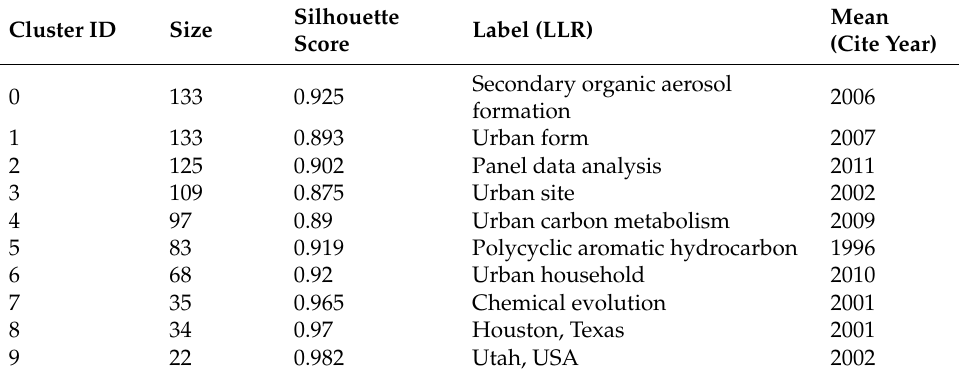
Table 2. Summary of the largest 10 clusters.